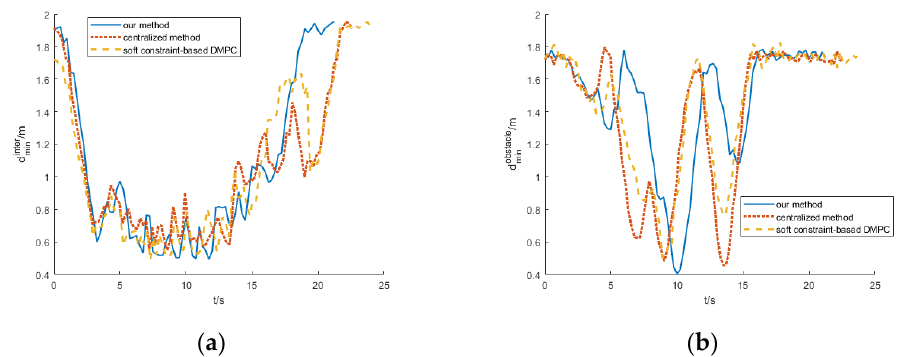
Figure 10. Comparison of the minimum distance between different methods. ( a ) the minimum distance between robots, ( b ) the minimum distance between robot and obstacle.